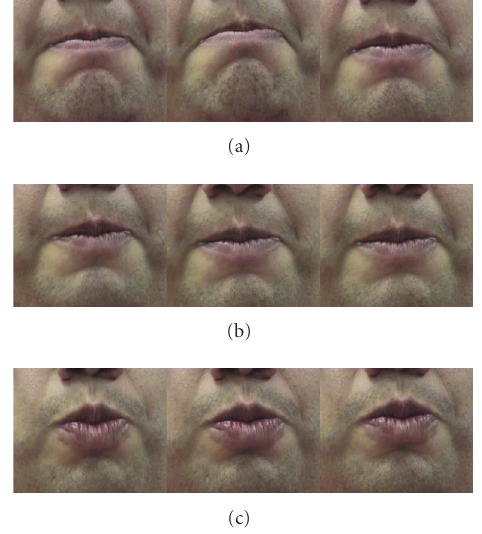
Figure 4: Contextual di ff erences in the pronunciation of the phonene m: (a) the m of “ama”; (b) the m of “eme”; (c) the m of “omo.” In each case, Person B pronounced the word 3 times to show potential.